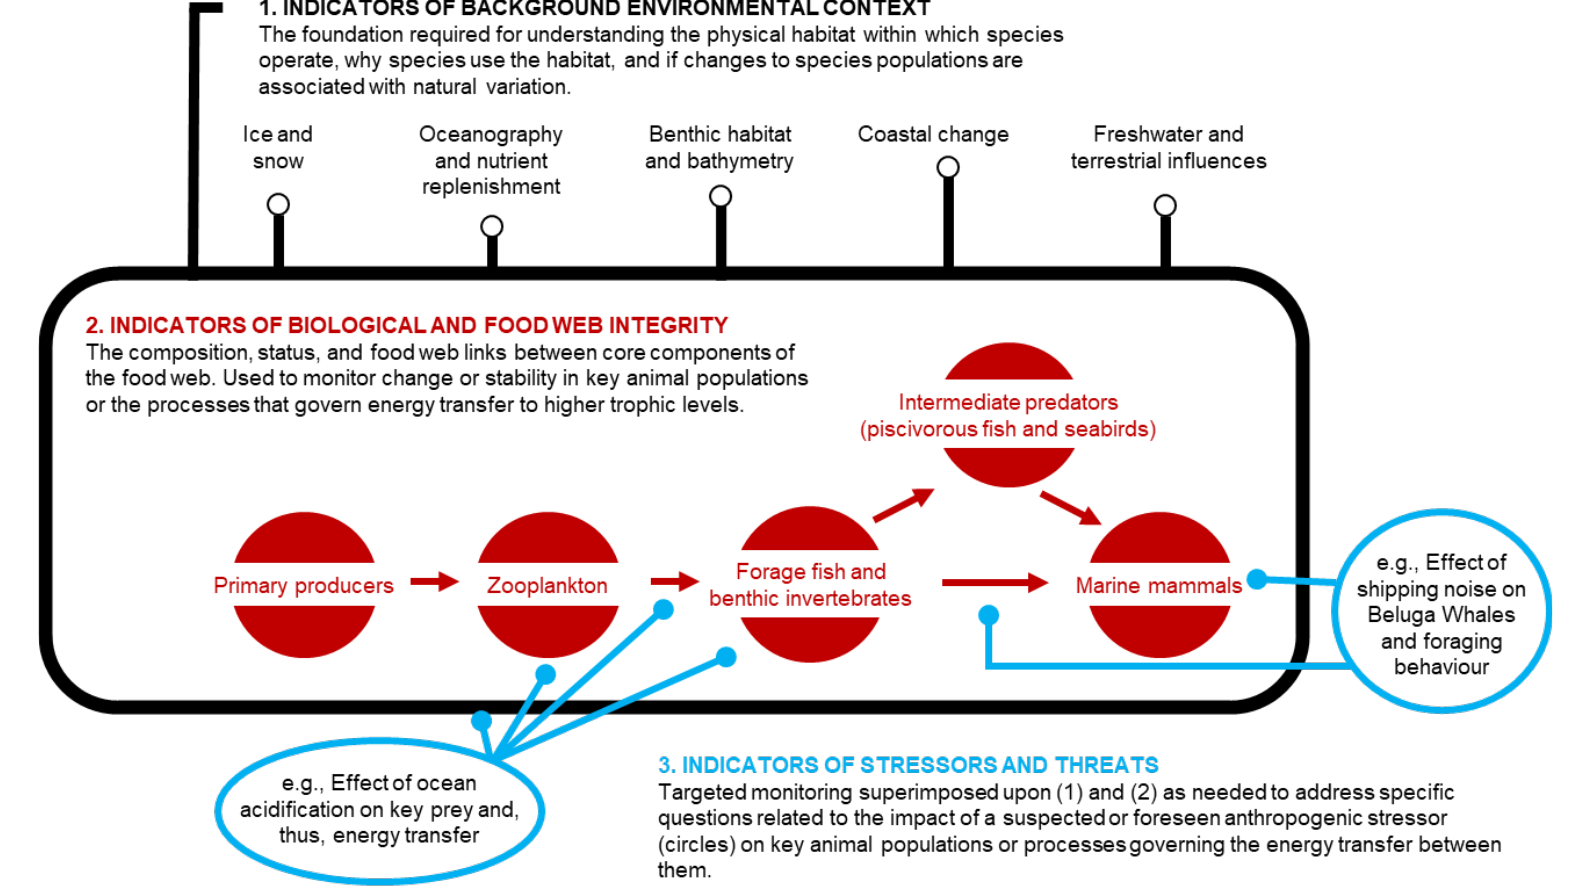
Figure 3. Schematic of the three-tiered indicator concept that guided indicator recommendations. (1) Indicators that provide background environmental context lay the foundation for an ecosystem-based management approach to monitoring and are necessary to link observed species trends to natural environmental variation or anthropogenic drivers. These indicators describe the habitat parameters (black box) within which biological communities (red) operate. (2) Indicators of biological and food web integrity are at the “core” of the monitoring program, directly tracking change in the biological communities and key species that occupy each major trophic group (circles), as well as the trophic processes that control energy transfer through the food web (arrows). Note that not all trophic components are pictured. (3) Indicators of stressors and threats are modular indicators superimposed on (1) and (2) that can be added or removed to guide targeted monitoring of how a specific stressor/threat (blue) impacts species (red circles), their habitats (black box), or process that govern energy transfer (red